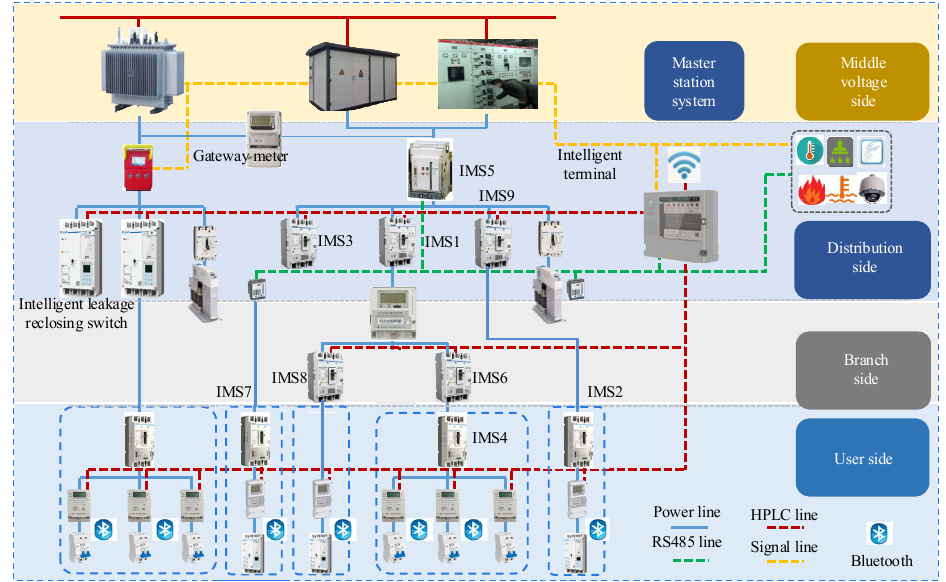
Figure 13. Topology test platform (IMS1 represents intelligent measurement switch ① ). Table 4. Topology Data Sheet.